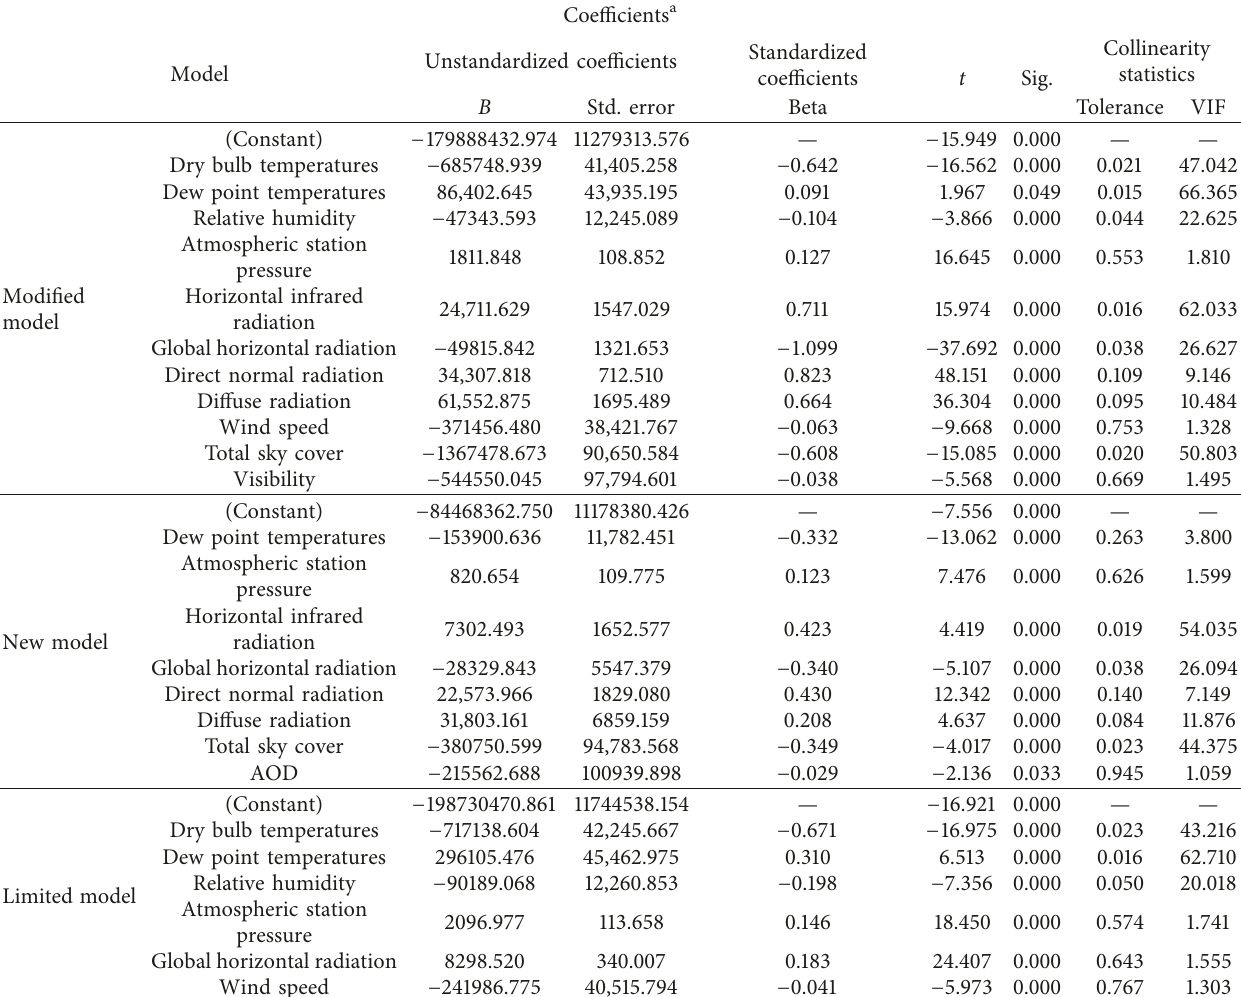
Table 9: Regression coefficients for a DOE small office building depending on different